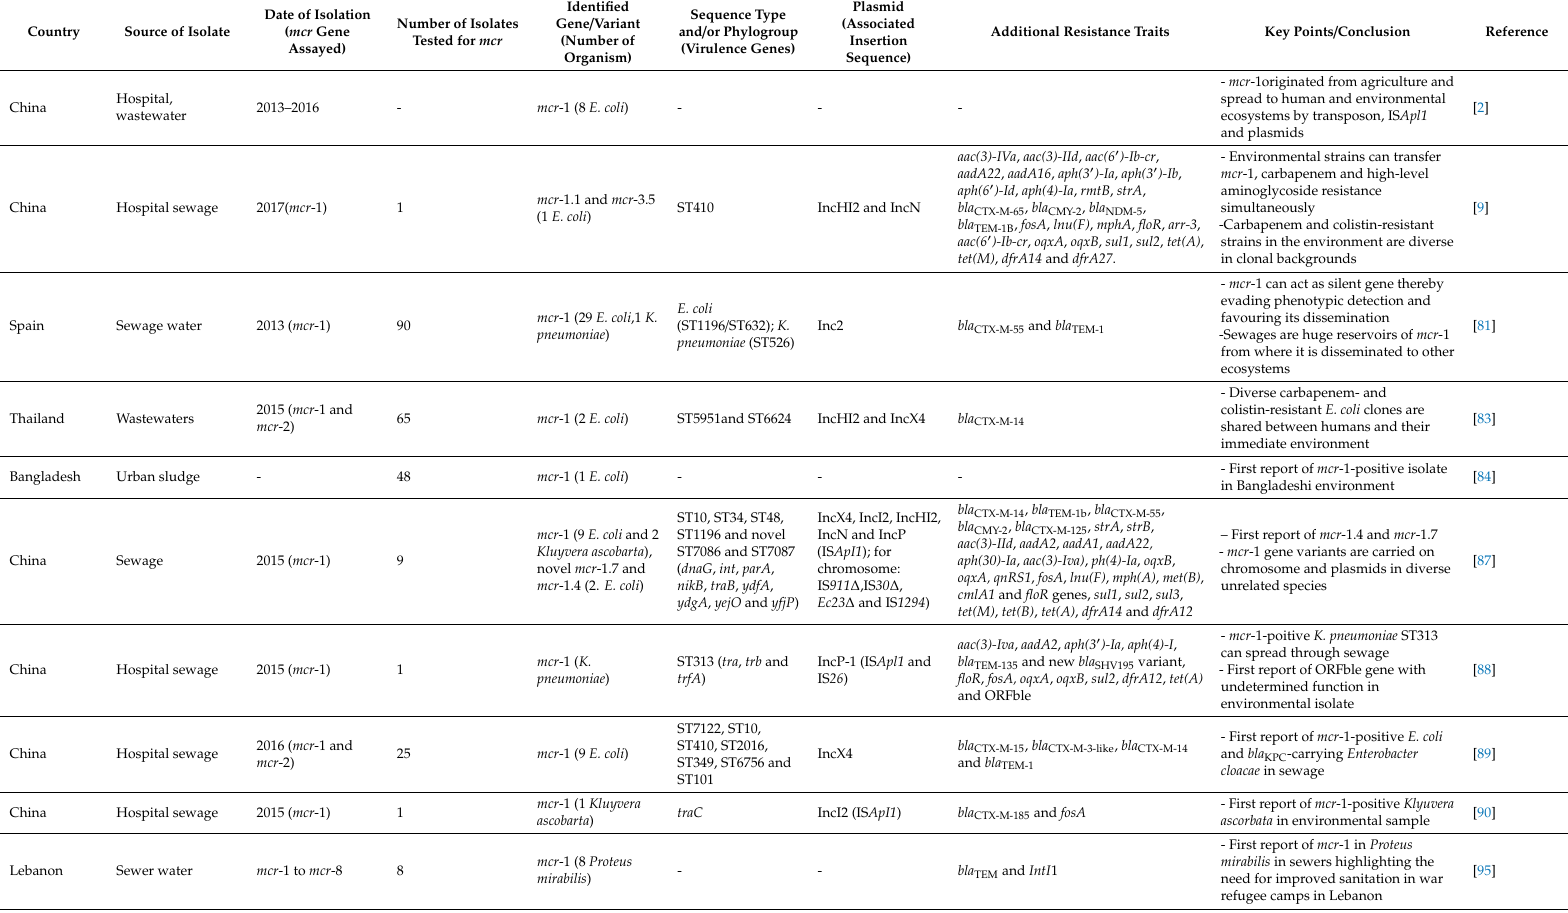
Table 2. Studies reporting plasmid-mediated colistin resistance in sewages / wastewaters.